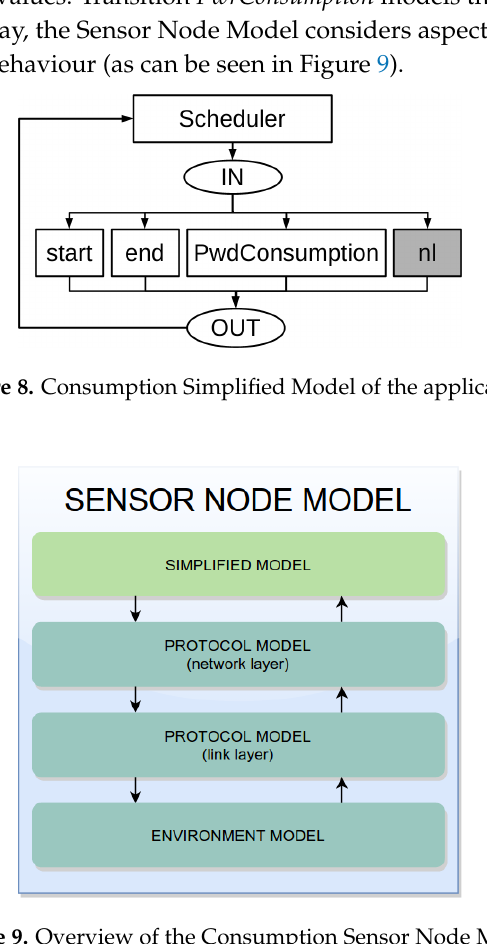
Figure 9. Overview of the Consumption Sensor Node